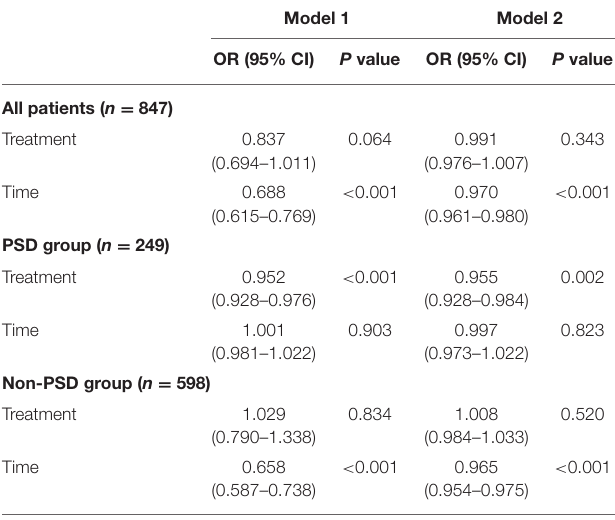
TABLE 3 | Generalized logistical mixed-effect model of the relationship between SSRIs and PSF during the 24-month follow-up period.